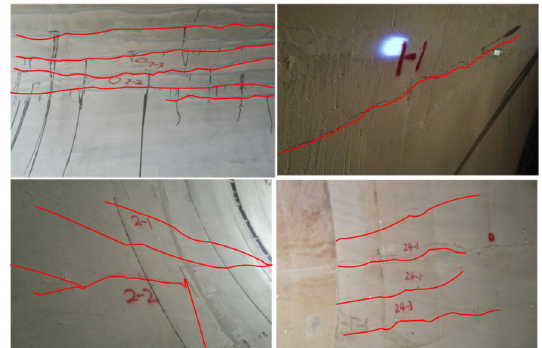
Figure 12. Types of cracks in the tunnel lining. Table 2. Mechanical properties of T300 carbon fibre.